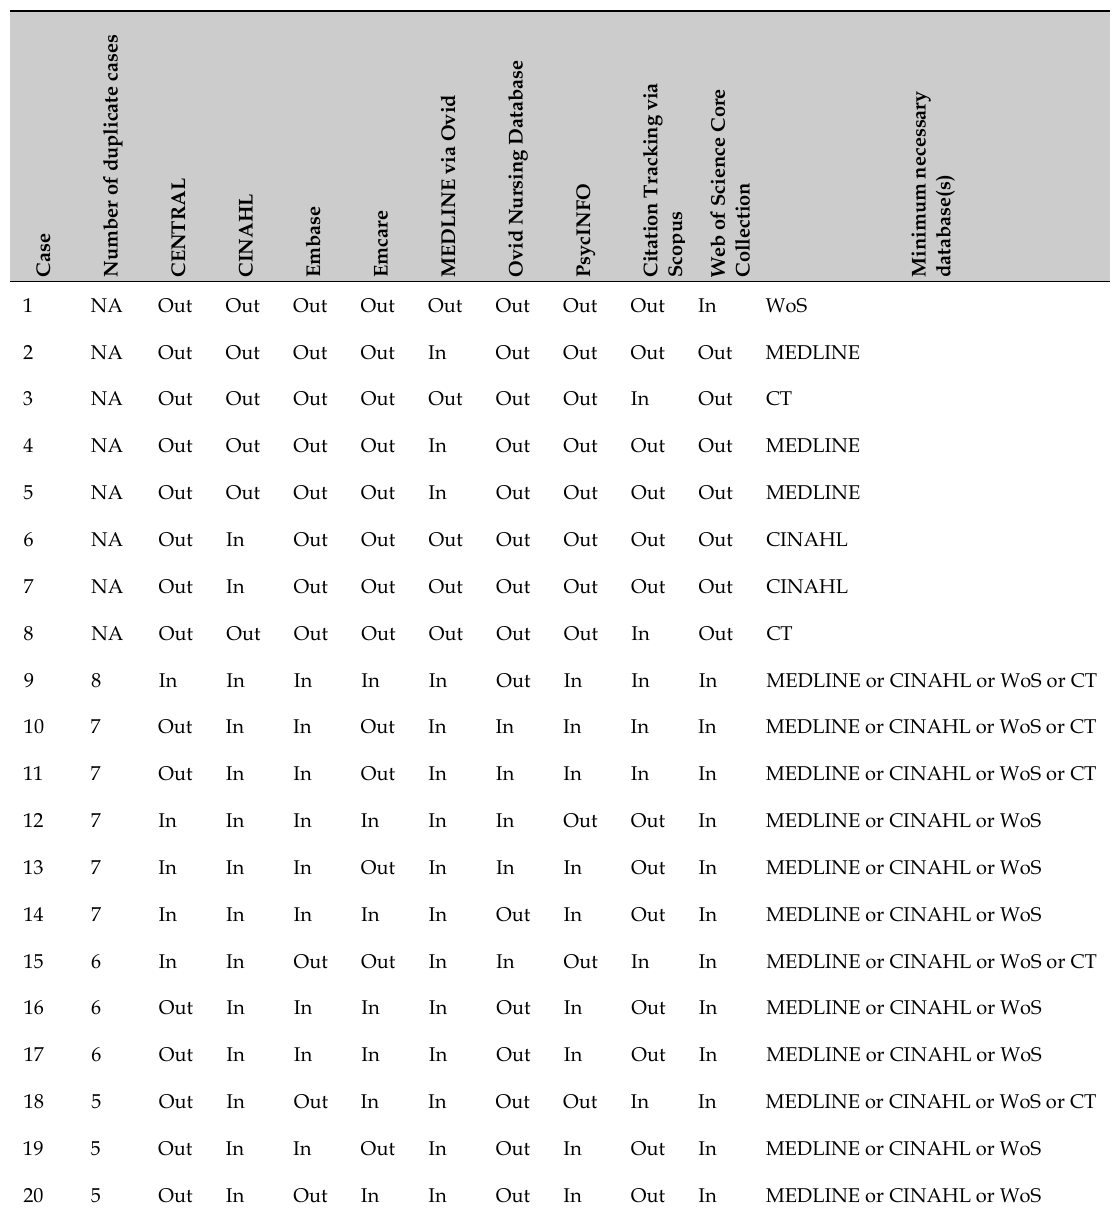
Table 4 Indexing (In) and non-indexing (Out) of unique and duplicate cases within included studies in our scoping